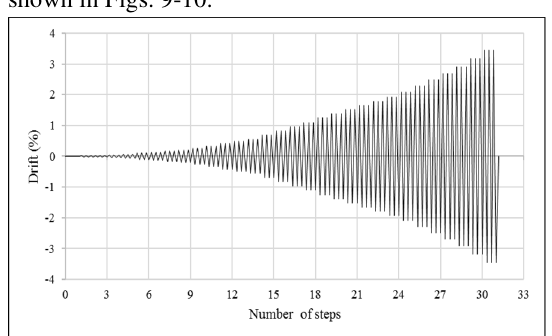
FIG. 7(A). GROUTING MACHINE TABLE 1: MECHANICAL PROPERTIES OF MATERIALS Mechanical Properties